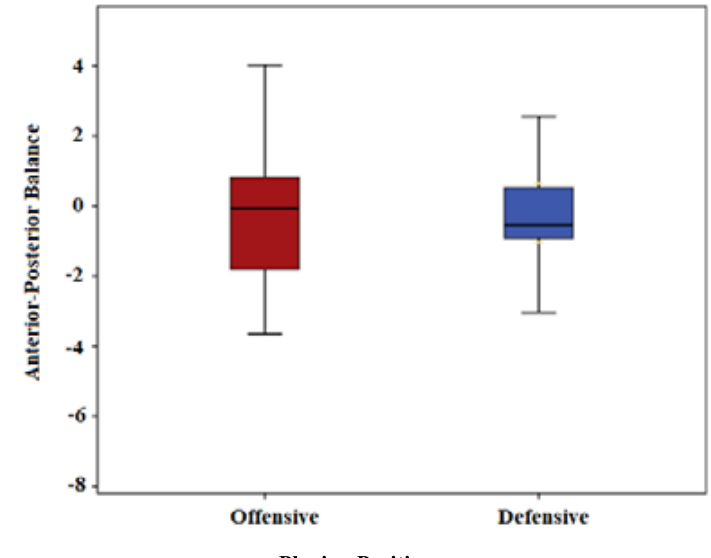
Playing Positions Figure 8. Comparison of Anterior-Posterior balance performance ( o ) of players according to playing positions